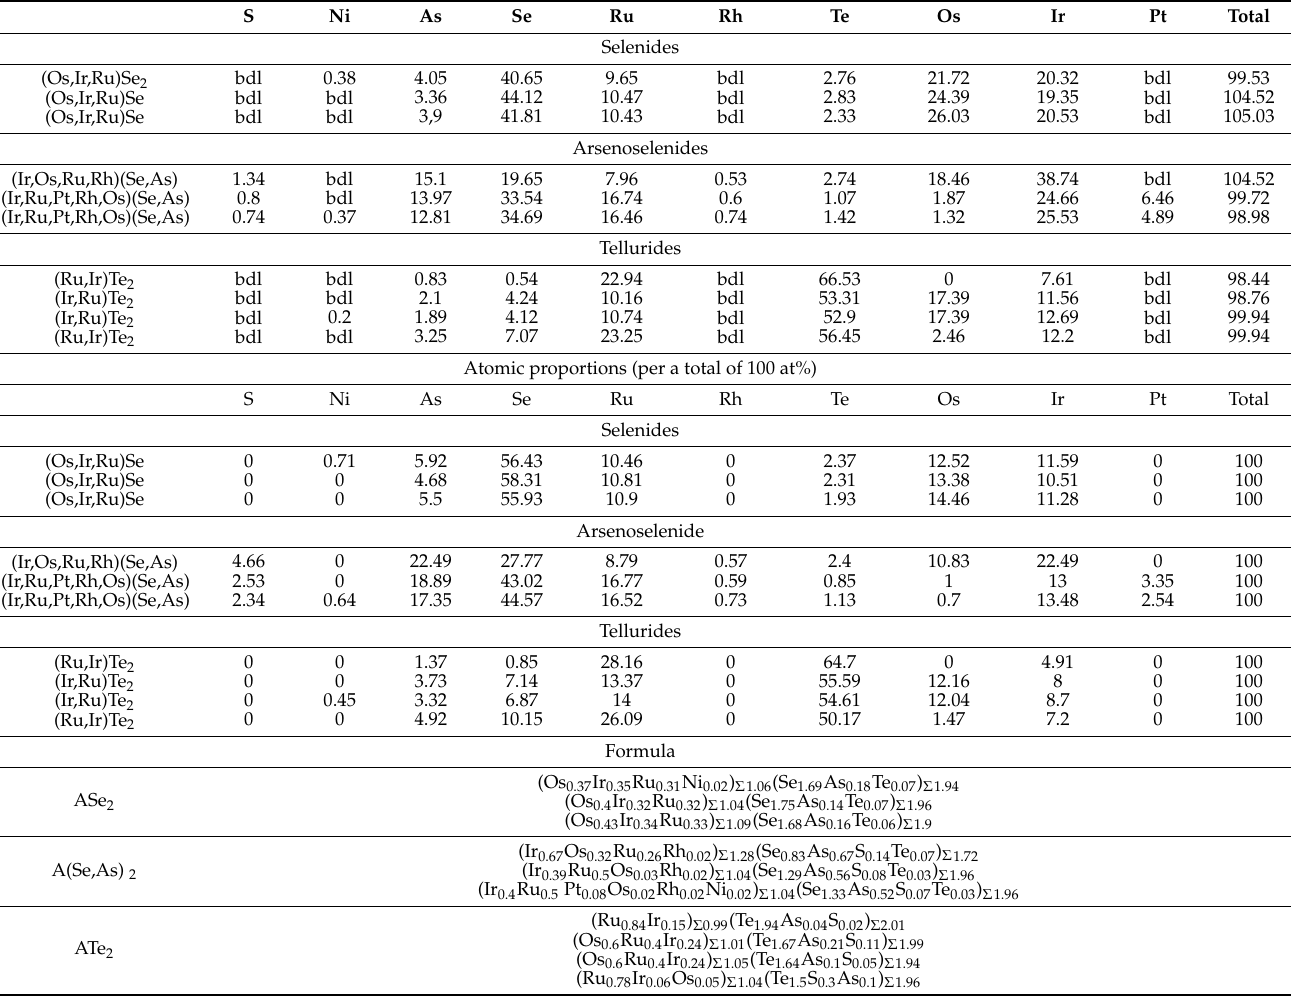
Table 5. Compositions of tellurides, selenides, and arsenosulfoselenides PGM in grains of Ru-Os-Ir alloy minerals from the placer of the Kitoy